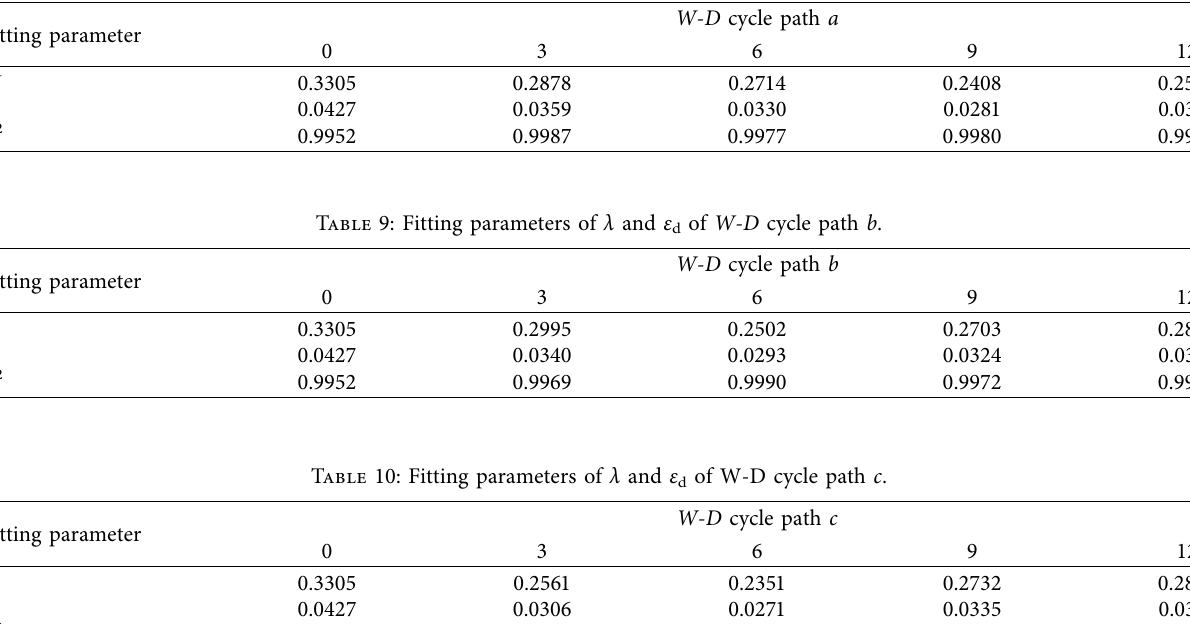
Table 11: Fitting parameters of λ and ε